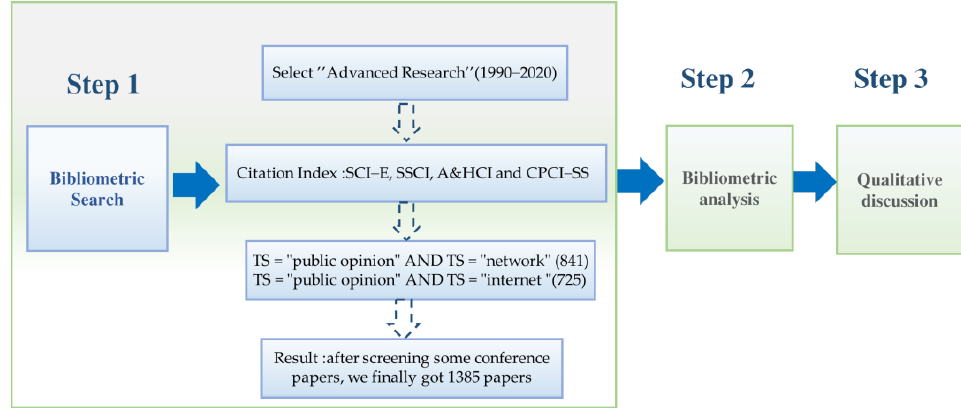
Figure 2. Research methodology of NPO.